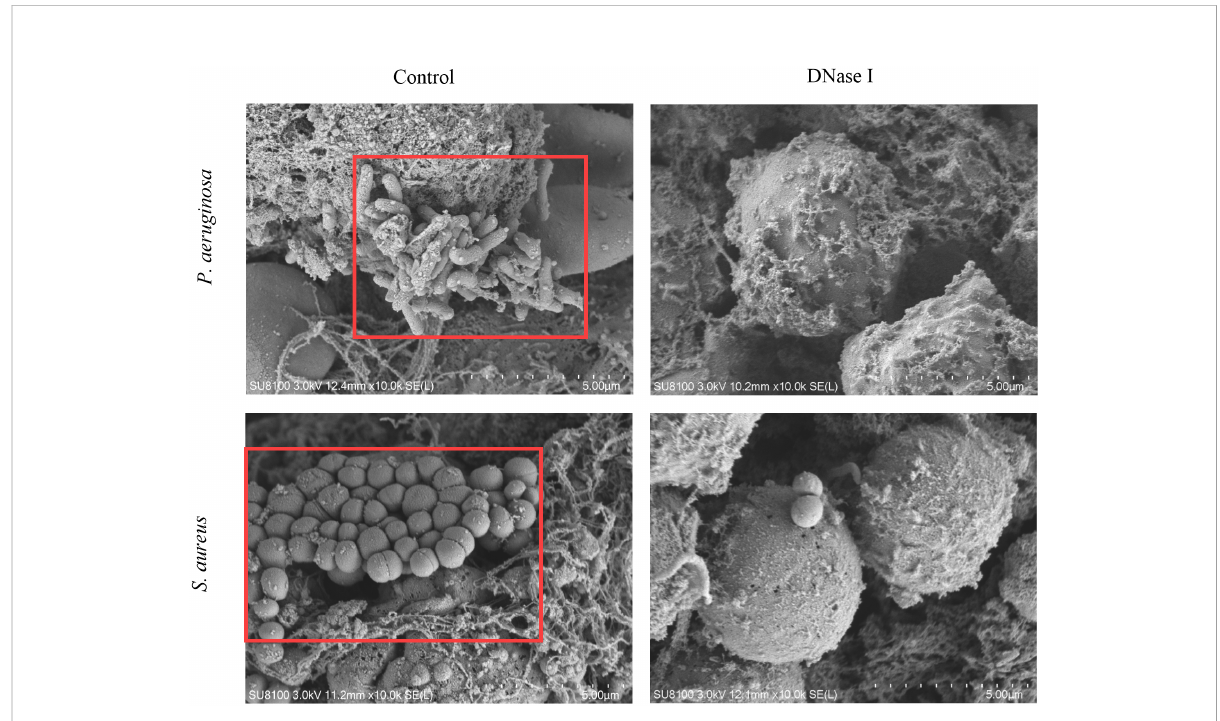
FIGURE 12 Pleural surface as seen using SEM (10,000×). In the control rabbits, we observed bio fi lm-like structures on the pleural surface. The P. aeruginosa or S. aureus strains were embedded in an electron-dense extracellular matrix (red box) in apparent bio fi lm-like structures. In the DNase-I treated rabbits, we observed only a few bacteria surrounded by a loose matrix.